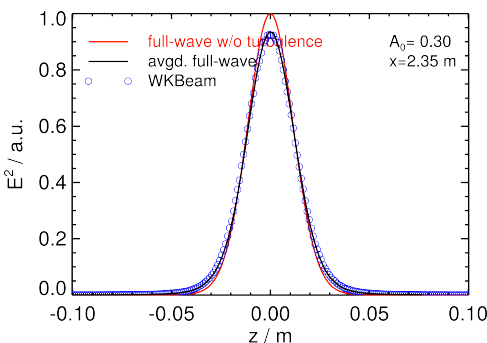
Figure 2. Beam cross section at a radial position of x = 2 . 35m from full-wave simulations (ensemble-averaged) and WKBeam